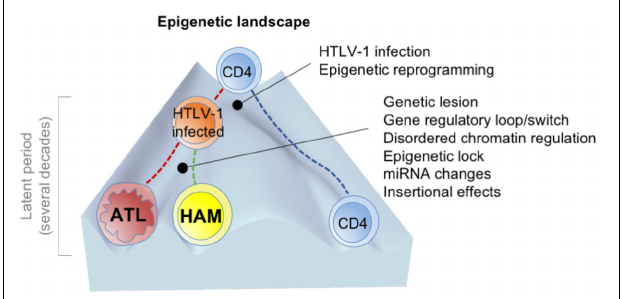
FIGURE 2 | A hypothetical model of developmental pathway in HTLV-1-associated diseases [adapted from Waddington (1957)]. The height of the walls between the valleys (or canals) is determined by several molecular events. The first HTLV-1 infection and the accompanied epigenetic alterations change the cell fate. The permissive state induced by HTLV-1-infection allows following stochastic perturbations such as genetic mutations and dysregulation of the signaling pathways and clonal selection, paralleled by a decrease in transcriptional noise, and the stabilization of cell states (deepening of the valleys).